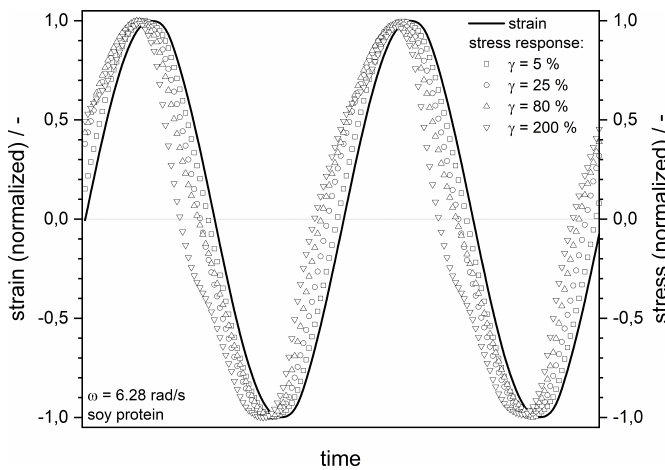
Figure A1: Excerpt of raw data of strain sweeps for soy protein, normalized strain and normalized stress plotted over time.